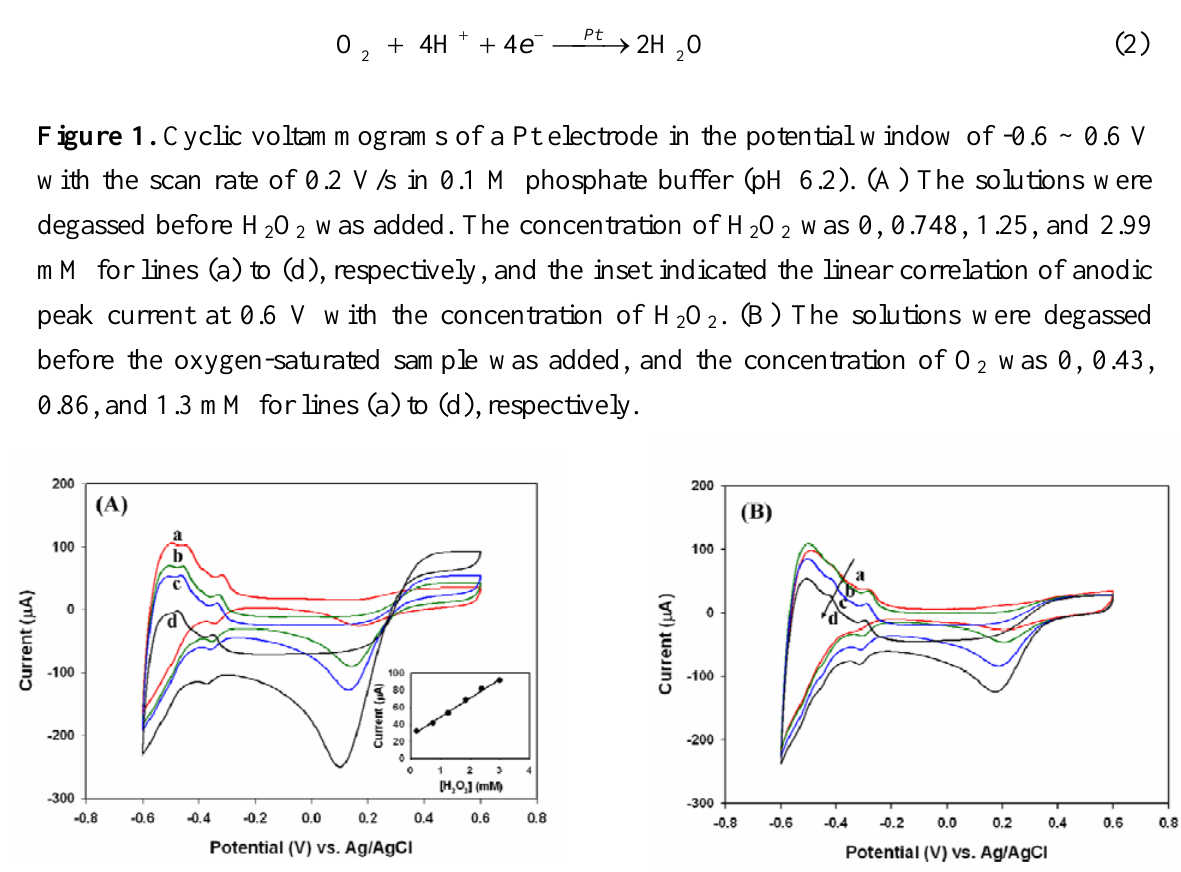
Figure 1. Cyclic voltammograms of a Pt electrode in the potential window of -0.6 ~ 0.6 V with the scan rate of 0.2 V/s in 0.1 M phosphate buffer (pH 6.2). (A) The solutions